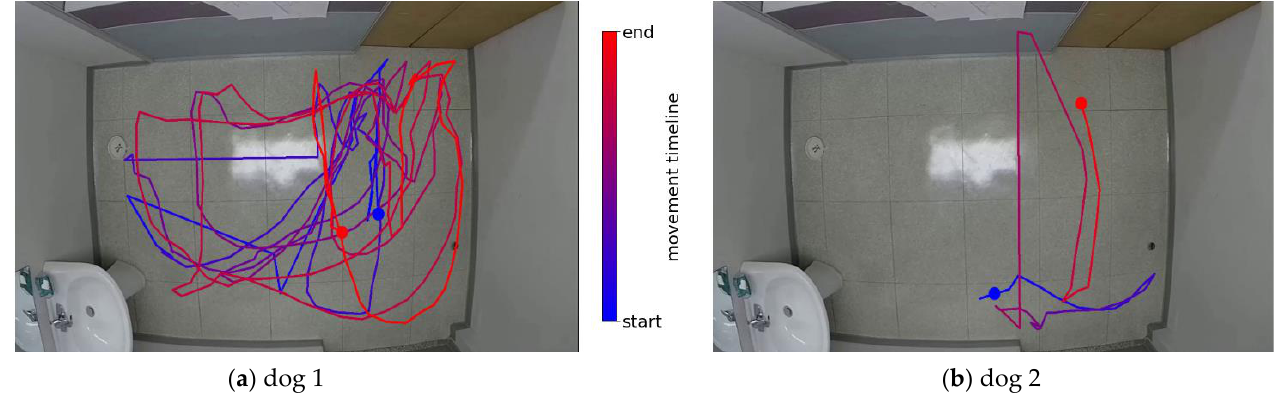
Figure 9. Trajectory visualization tool for displaying dog’s movement patterns: ( a ) example of sce- nario with dog 1; ( b ) example of scenario with dog